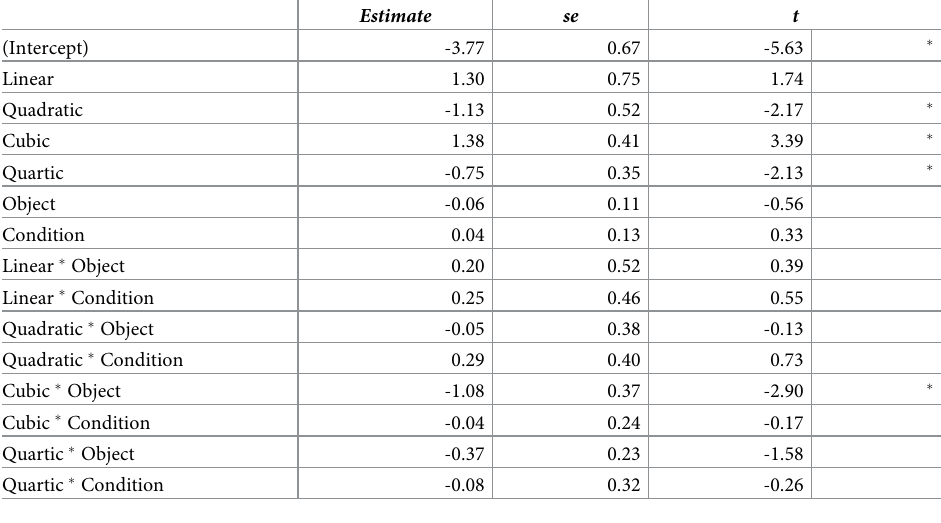
Table 3. Main and interaction effect in the quasi-logistic GCA mixed model analysis in Experiment 2B. Estimate se